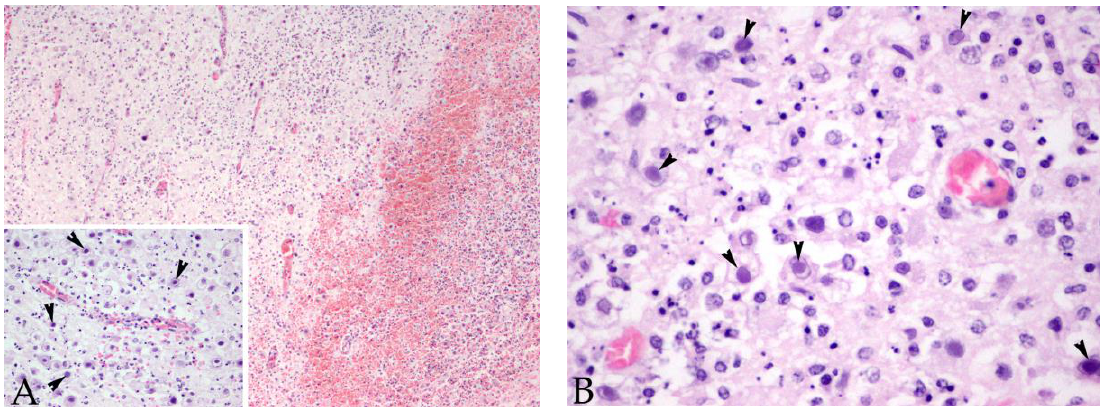
Figure 1. Brain cerebral cortex sample of case 4, a male striped dolphin calf presenting 7/7 of the evaluated brain lesions. ( A ) Suffusive haemorrhages and malacia are present. Original magnification × 10; haematoxylin and eosin staining. Inset: numerous basophilic intranuclear inclusion bodies were observed within the neurons and glial cells (arrowheads). Original magnification × 40; haematoxylin and eosin staining. ( B ) Higher magnification of the basophilic intranuclear inclusion bodies (arrowheads). Original magnification × 60; haematoxylin and eosin staining.